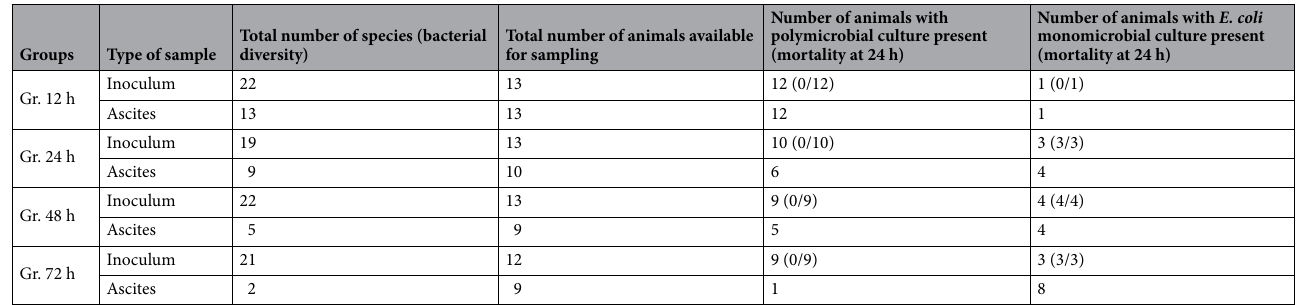
Table 1. Bacterial diversity and sepsis-related mortality. Bacterial diversity is represented by the total number of bacterial species present in the inoculum and ascites samples in the different sepsis groups (Grs. 12–72 h). Mortality data (ratio of the numbers of animals which had to be humanely euthanized at 24 h after sepsis induction compared to the total number of animals in the given group) are indicated in brackets in the lines for the corresponding